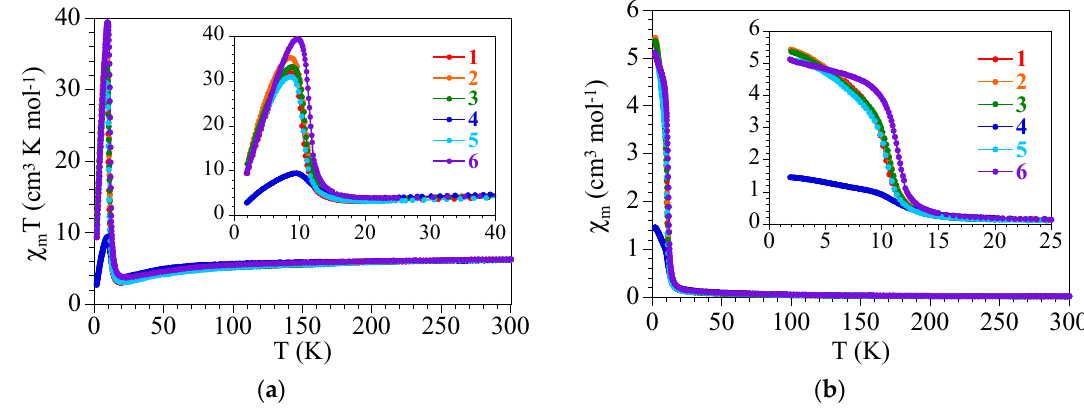
Figure 6 . ( a ) Thermal variation of the χ m T product ( a ) and χ m ( b ) for compounds 1 – 6 . Insets show zooms of the low temperature regions.